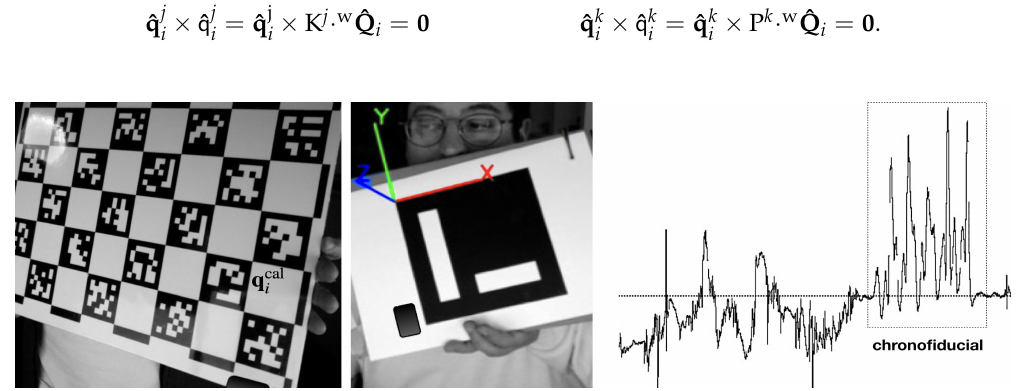
Figure 6. Summary of the method for multi-camera and inertial sensor registration. The (acceleration) signal on the right plot shows a pre-arranged number of spikes that are generated by gently waving the calibration board a prearranged number of times. During this operation, the board appears blurry and the intelligent framework (inevitably) stops identifying fiducials. The spiky pattern in the inertial signal (and the moment when it occurred) can be automatically detected. The time series is recorded by a rigidly attached accelerometer (in this case, an AX3 device glued to the board pictured at the left). The small tracking board at the center also contains a glued AX3 accelerometer on its